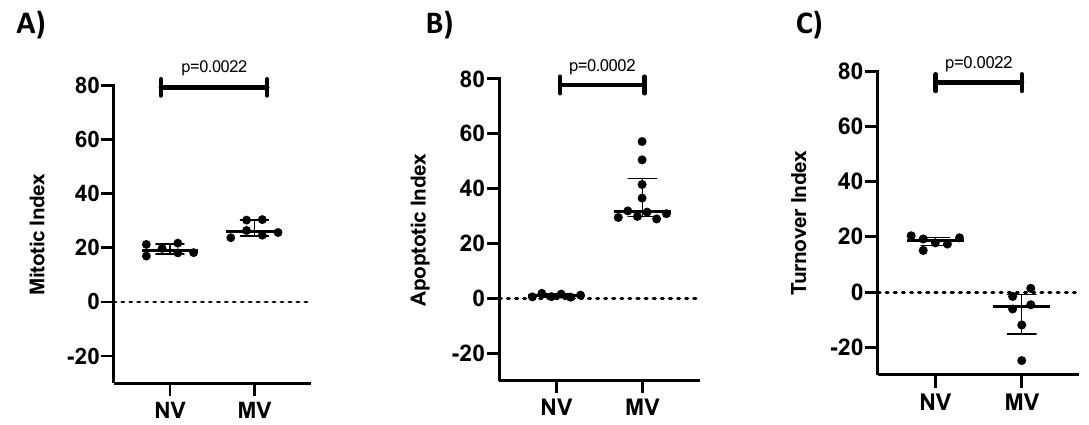
Figure 3. ( A ) Dot plot showing mitotic indices of 19.07 (17.84–21.38) in the NV group and 26.04 (24.42–30.34) in the MV group, p = 0.0022 (n = 6 per group). ( B ) Dot plot showing apoptotic indices of 0.96 (0.50–1.61) in the NV group and 31.70 (29.79–43.76) in the MV group p = 0.0002 (n = 6–10 per group). ( C ) Dot plot showing turnover indices of + 18.59 (16.86–19.92) in the NV group and − 5.32 (− 15.16- − 0.77) in the MV group, p = 0.0022 (n = 6 per group).